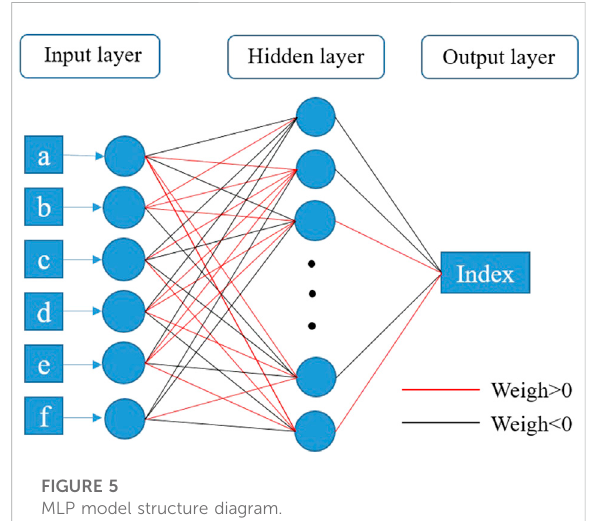
FIGURE 5 MLP model structure